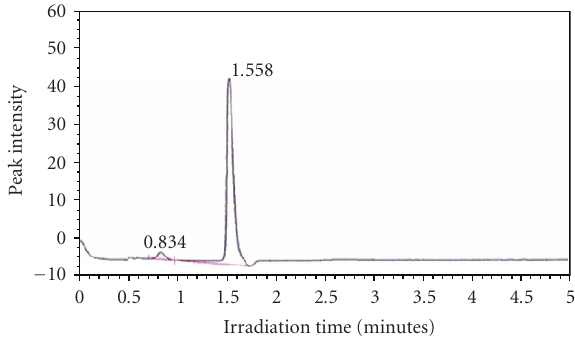
Figure 5: HPLC analysis of authentic glycine in aqueous solution.